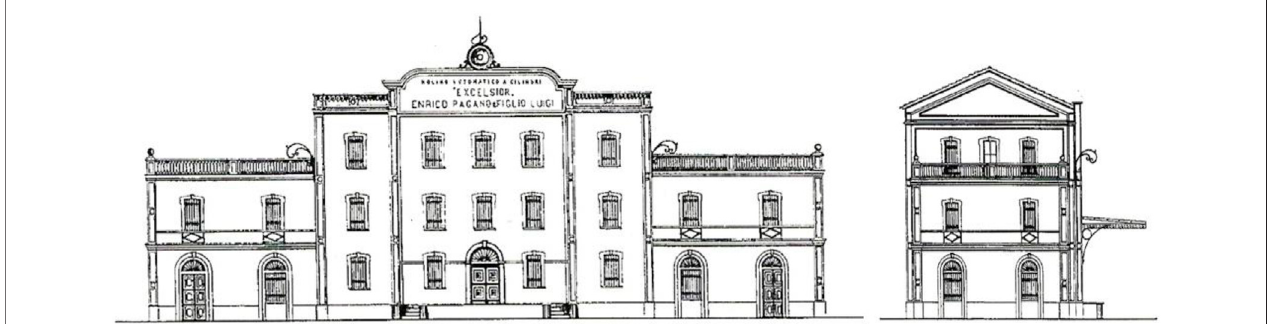
FIGURE 2 | Flour mill “ Excelsior ” located in southern Italy (Apulia region).